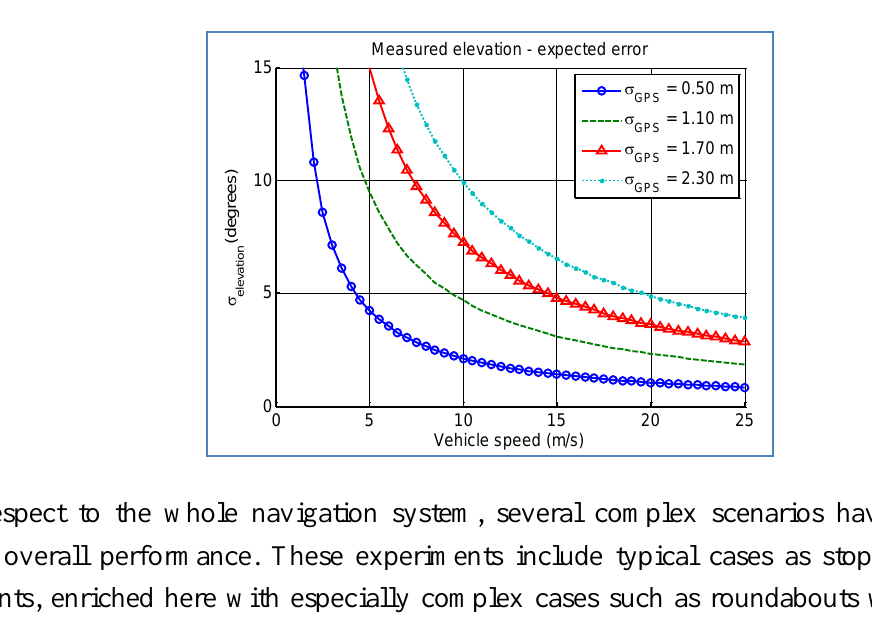
Figure 16. Expected standard deviation of GPS-obtained elevation angle, depending on vehicle speed and fix horizontal accuracy (simulation, 10 million iterations per point).